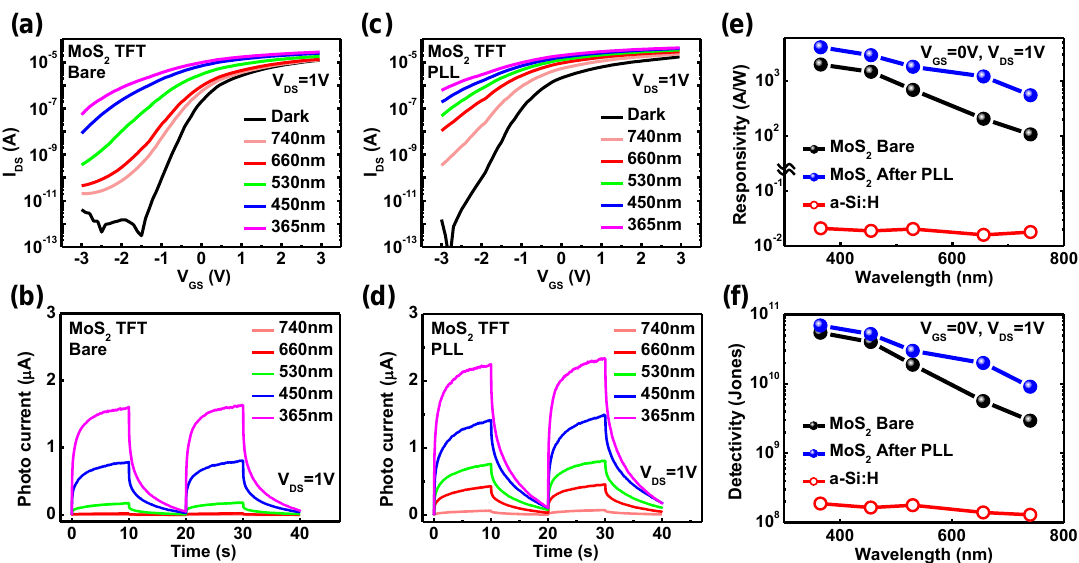
Figure 8. Photoresponses from ( a ) transfer characteristics and ( b ) two-terminal output characteristics of bare m-MoS 2 TFTs under illumination from 740 nm to 365 nm. Photoresponses from ( c ) transfer characteristics and ( d ) two-terminal output characteristics of PLL-treated m-MoS 2 TFTs. Comparisons of ( e ) responsivities and ( f ) detectivities of bare and PLL-treated m-MoS 2 TFTs and a-Si:H TFTs extracted at V GS = 0 V, V DS = 1 V for wavelength from 740 nm to 365 nm.